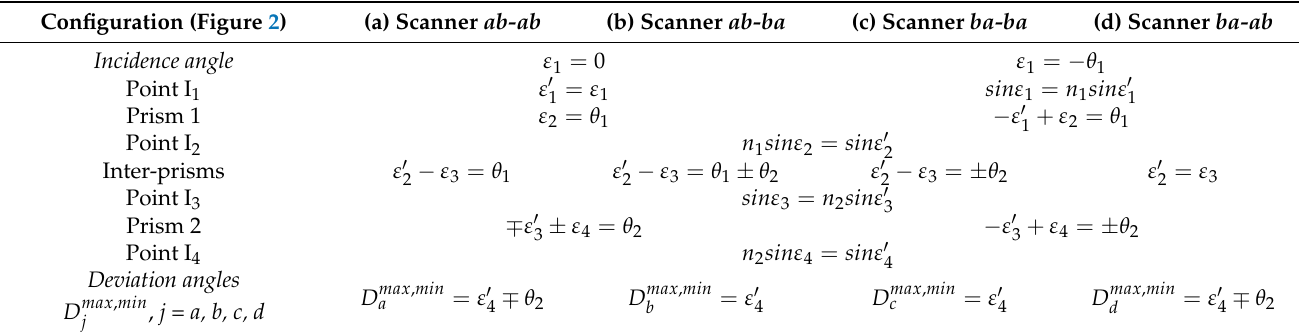
Table 1. Equations of the four possible configurations of scanners with a pair of rotational Risley prisms (Figure 2)—for the cases of the maximum ( 1 ) and minimum ( 2 ) angular